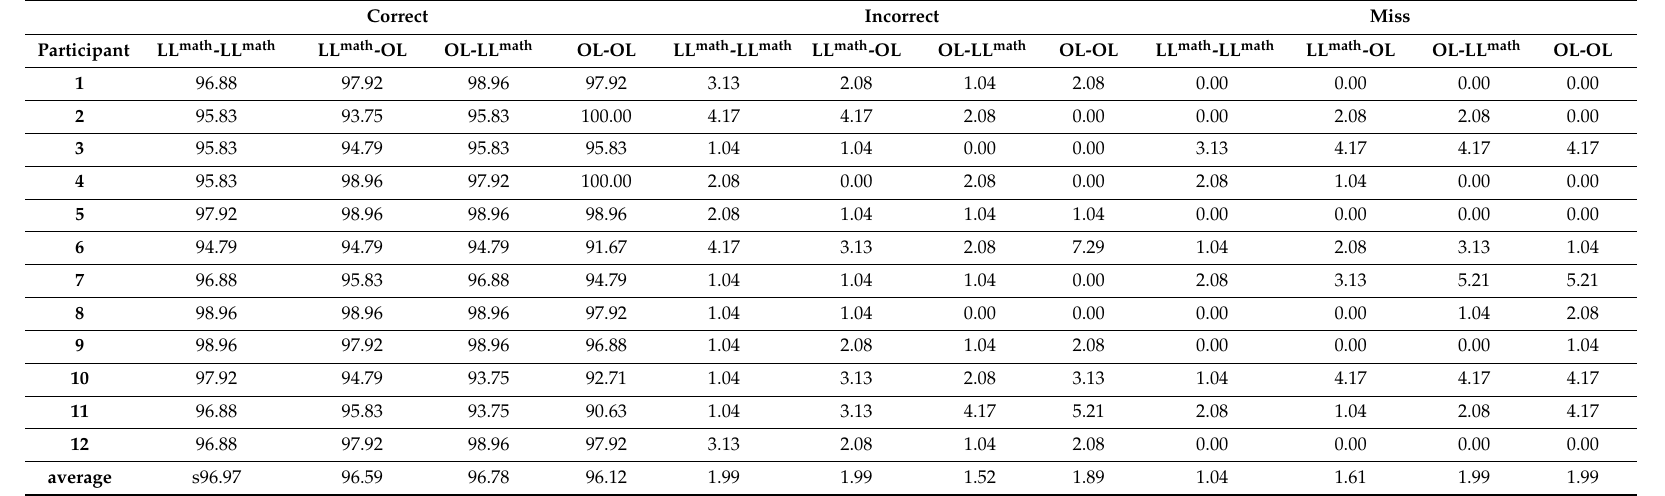
Table 3. Percentages of correct, incorrect and missing answers by condition and participant in